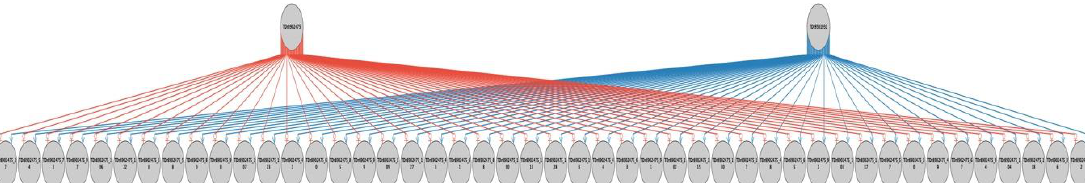
Figure 4. Pedigree reconstruction of polycross family TDr1687 based on Helium pedigree visualization. TDr9501932 = male parent (blue); TDr8902475 = female parent (red).